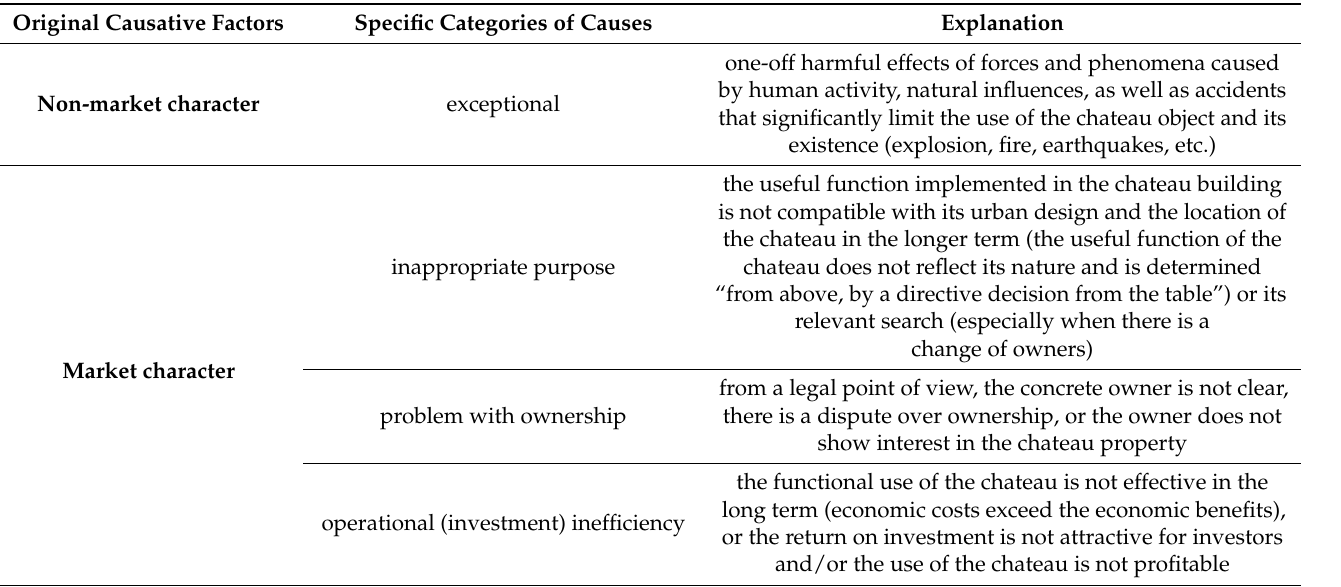
Table 2. Categorizing the causes of occurrence of chateau brownfields (adjusted